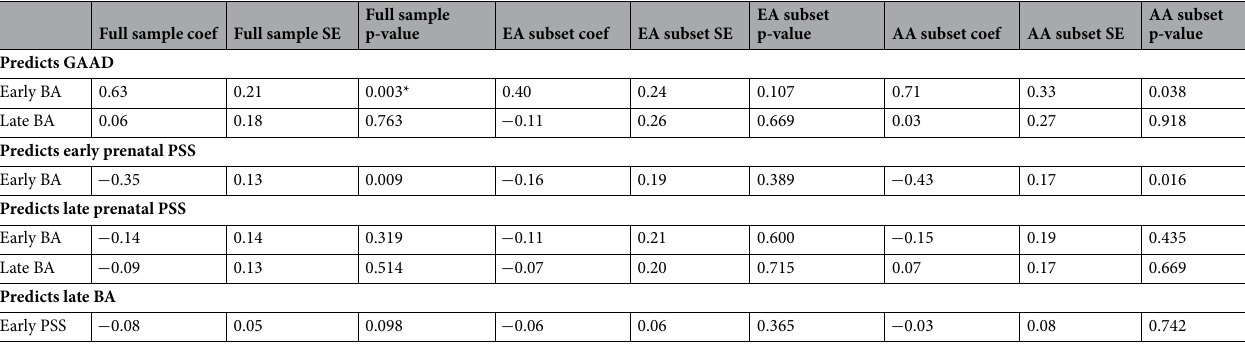
Table 2. Relationships between gestational age at delivery, perceived stress, and biological age estimates in the PREG cohort. Horvath probe sets were reduced to match the probes available for GAPPS. coef = coefficient, SE = standard error, EA = European American, AA = African American, PSS = perceived stress scale total score, GAAD = gestational age at delivery, BA = Horvath-derived biological age estimates. Maternal chronological ∗ age was included as a covariate in all models. Survives Bonferroni adjustment for 6 tests, p -val < 0.008 .